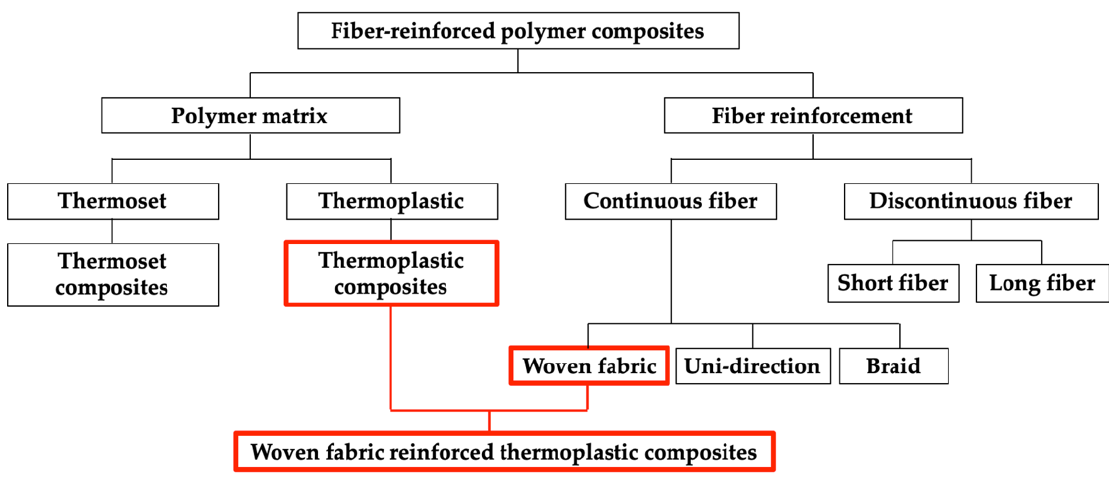
Figure 1. Classification of fiber-reinforced polymer composites.